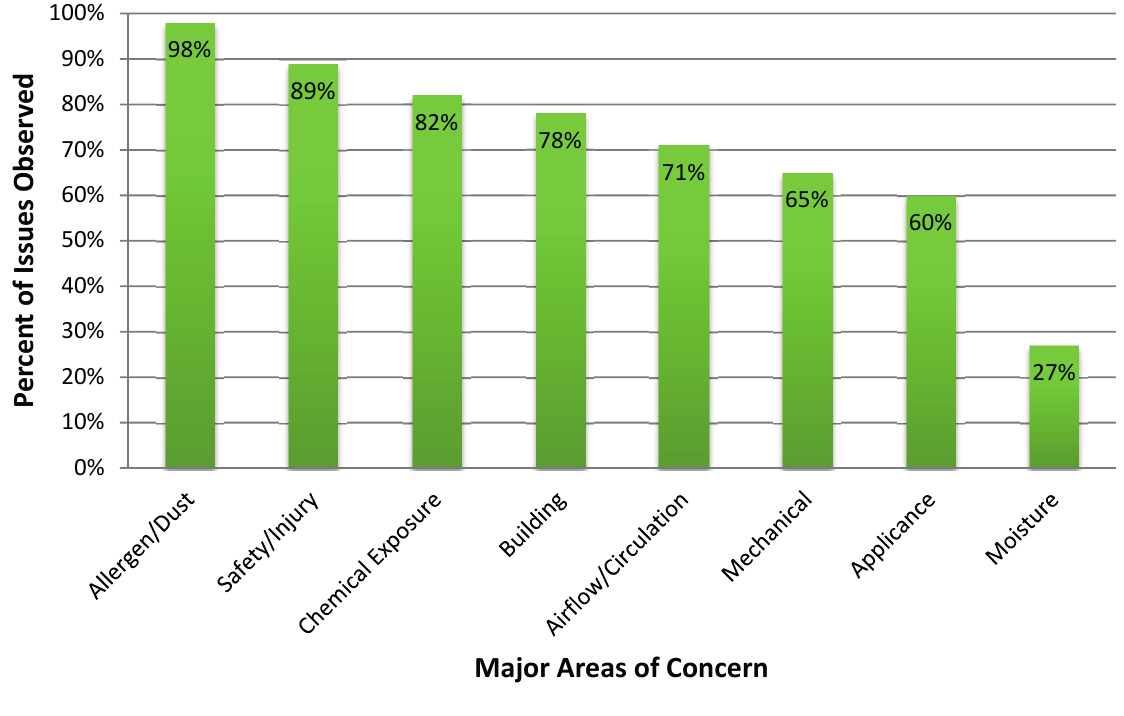
Figure 1. Percentage of homes/places of employment with issues observed during health home assessments by category of